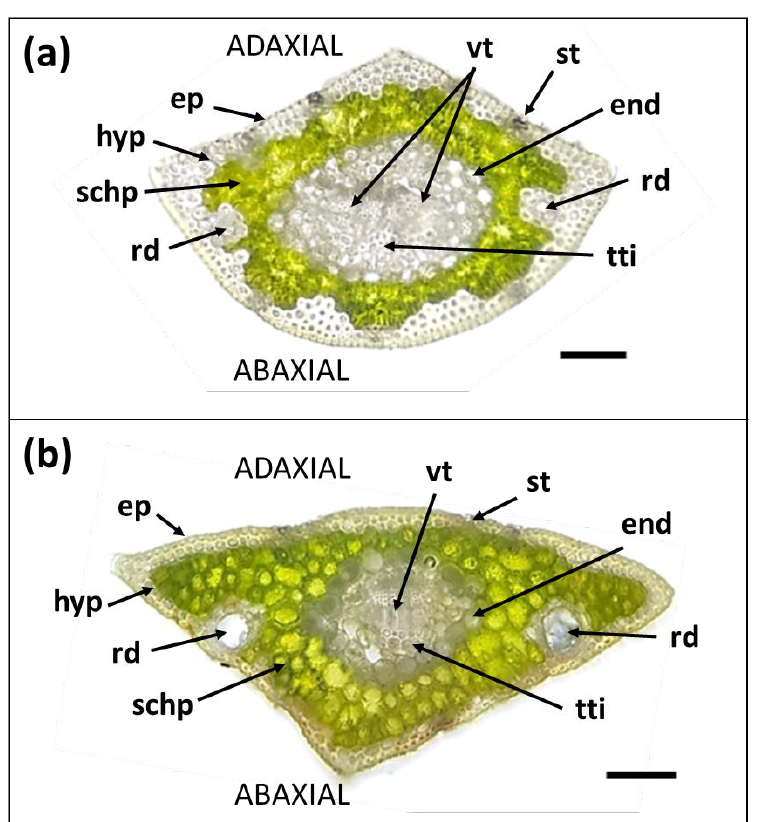
Figure 2. Fresh cross-sections of Pinus canariensis needles. ( a ) secondary (adult) needle. ( b ) primary (juvenile) needle. Abbreviations: end, endodermis; ep, epidermis; hyp, hypodermis; rd, resin duct; schp, spongy chlorophyll parenchyma; st, stomata; tti, transfusion tissue; vt, vascular tissue. Scale bars are 50 µm.